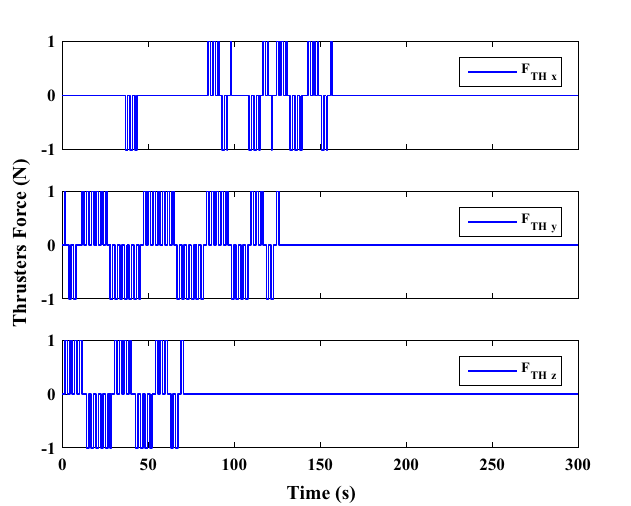
Figure 29. Scenario I: chaser’s thrusters force.